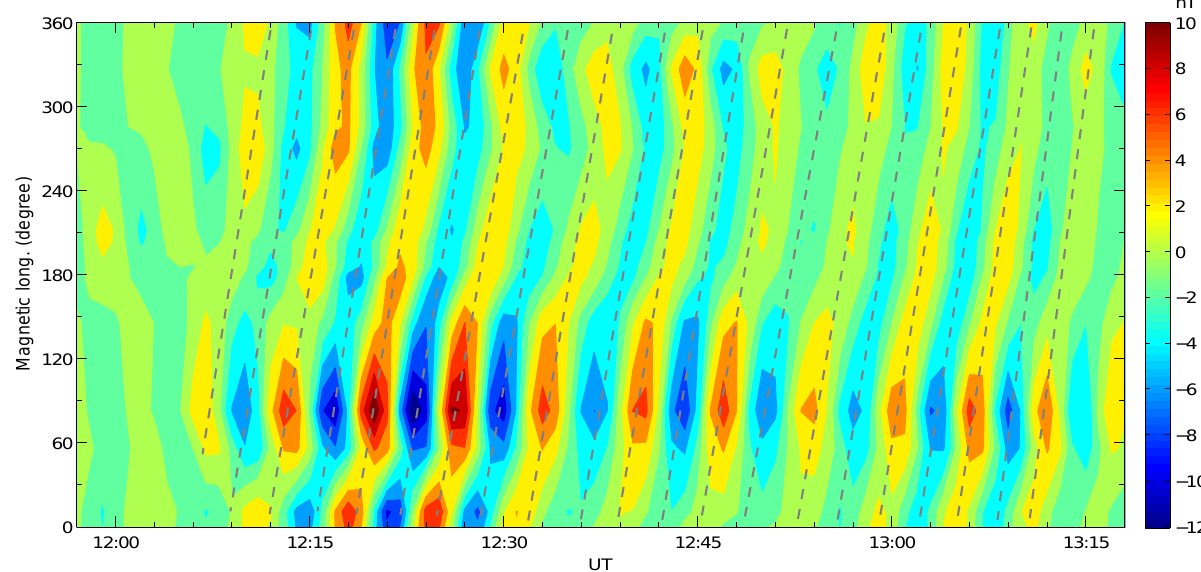
Fig. 8. Same as Fig. 4 but in time interval 12:00–13:15UT on 31 October 2005. The unambiguous eastward propagation of the mode (frequency range 2.1–3.2mHz) indicates the effect of electron